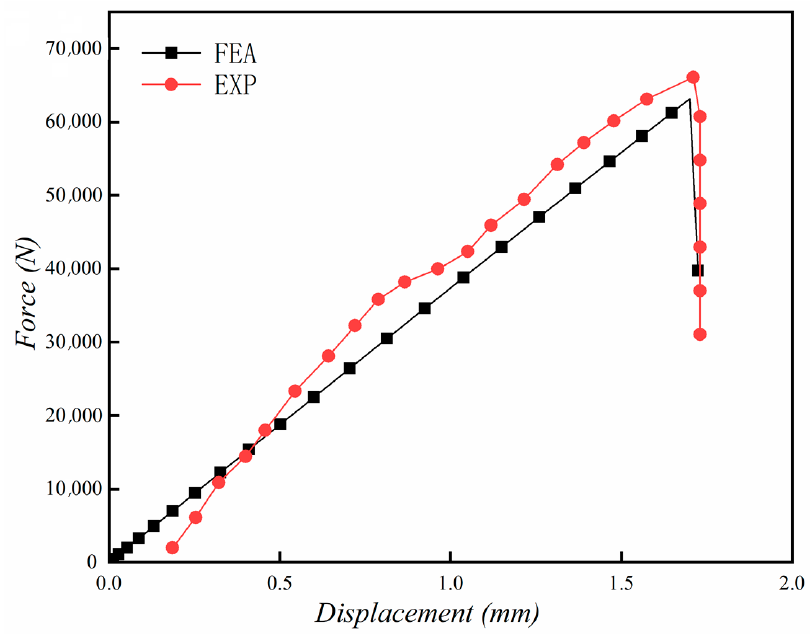
Figure 8. Load–displacement comparison between numerical simulation and test.